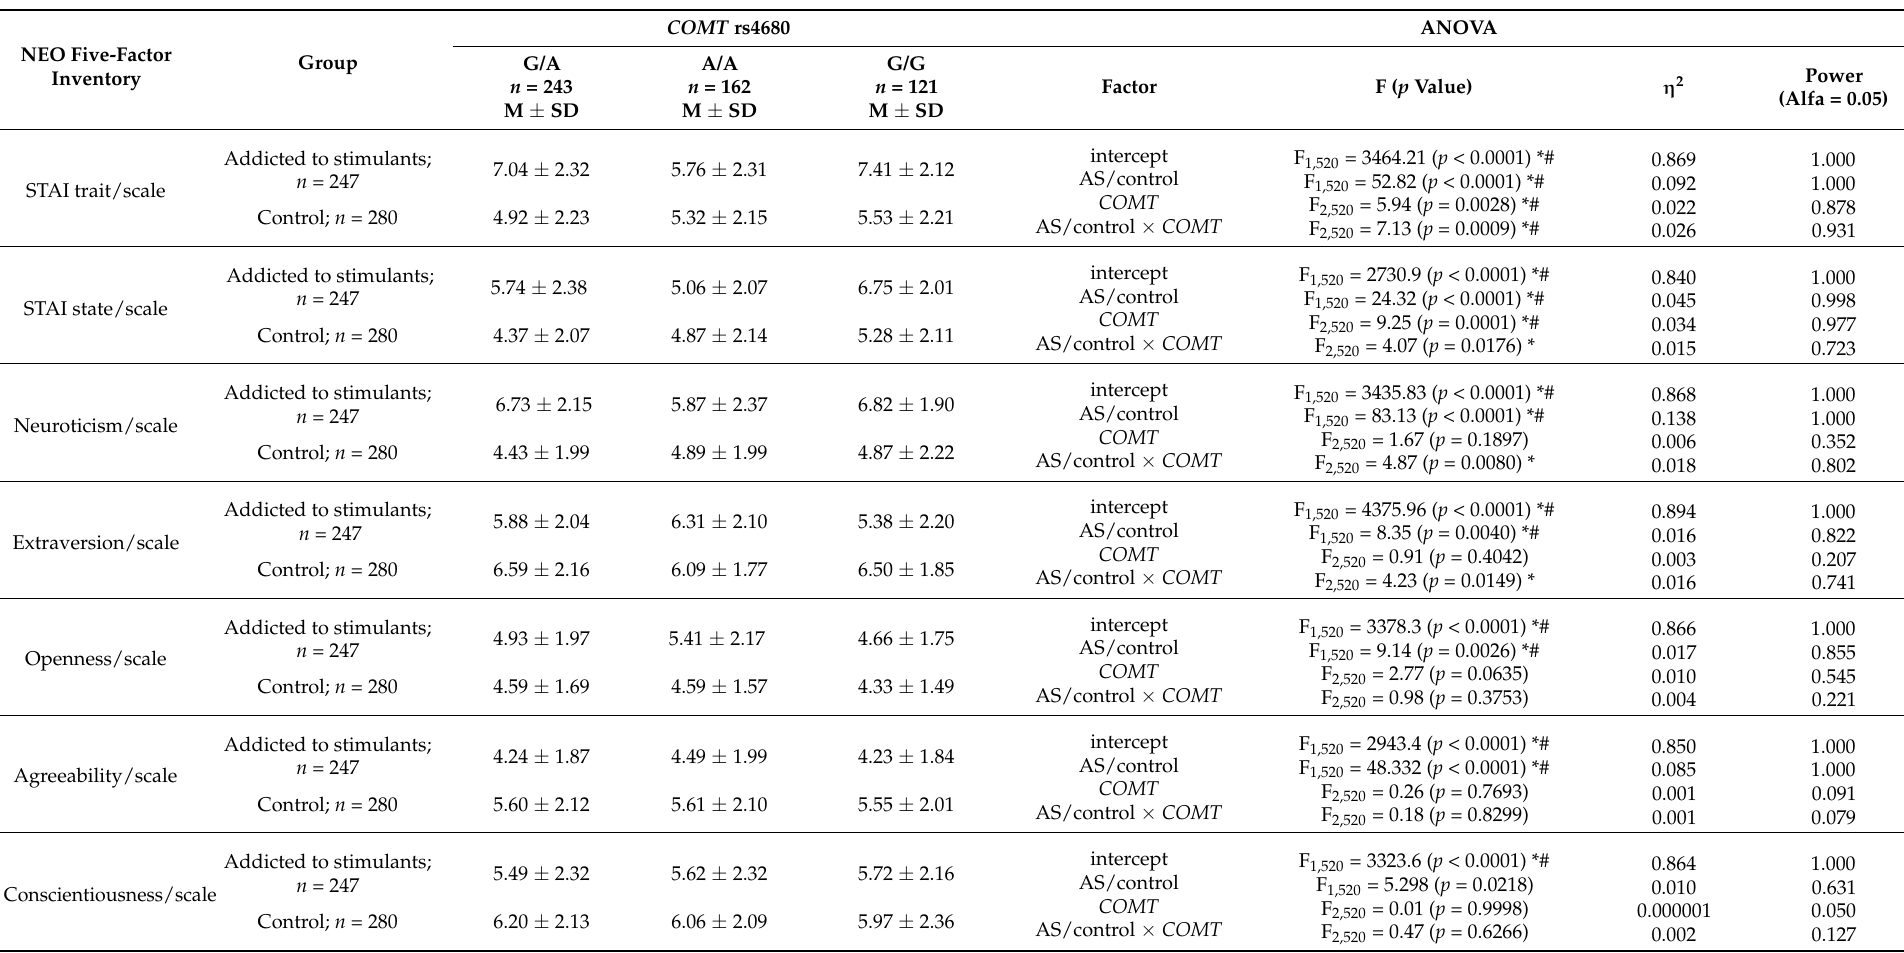
Table 6. The results of 2 × 3 factorial ANOVA for patients diagnosed with other stimulants dependence and controls for the STAI and NEO Five-Factor Inventory scale, and COMT